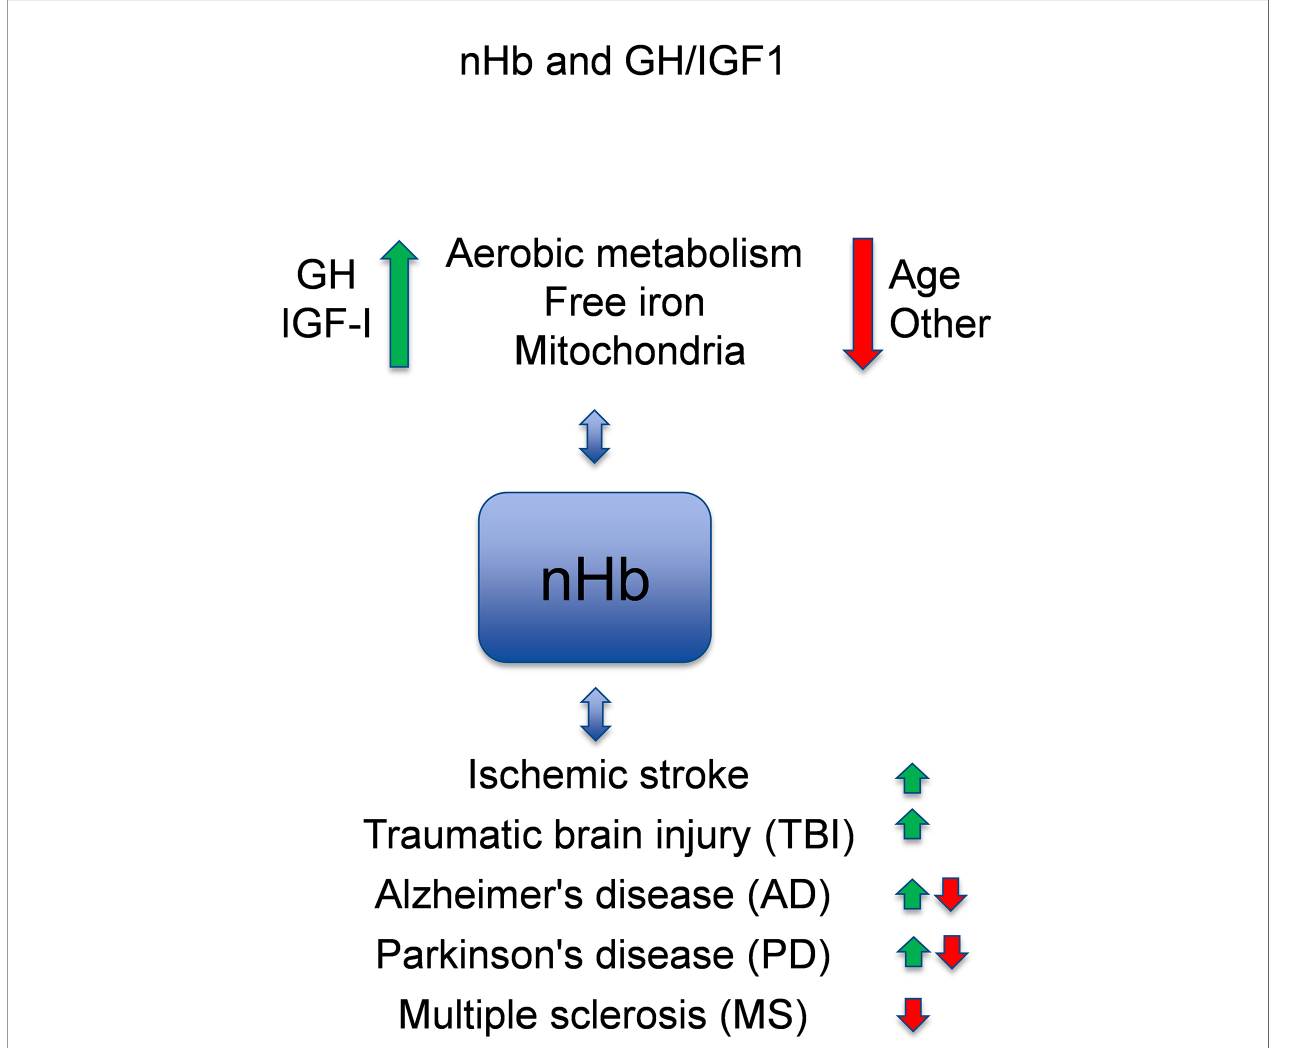
FIGURE 1 | Model of crosstalk between neuronal hemoglobin (nHb), growth hormone (GH), and insulin-like growth factor 1 (IGF-I), and the known relations to brain diseases. With respect to interactions with neuronal Hb (nHb), the green arrows are bene fi cial, and the red arrows are detrimental pathways. Please, observe that circulating or free HbA has other effects not included in this fi gure. In general, GH and IGF-I levels within the normal ranges are optimal for the metabolism of oxygen and iron and for the mitochondria, which is bene fi cial for the brain. With age or for other reasons (e.g., genes, environment), the levels of GH and IGF-I decline, and the metabolism deteriorates leading to lower levels of nHb. This has adverse effects on degenerative brain diseases (AD, PD, MS), although in some aspects nHb may also respond in a manner that slows the disease progression. References for the depicted relationships are given in the main